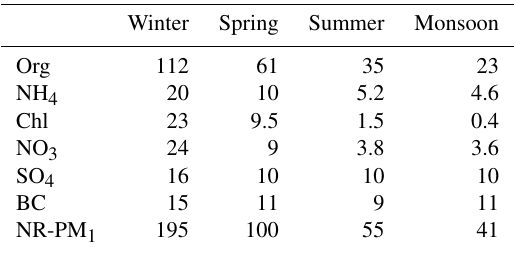
Table 1. Seasonal summary of PM 1 species – the arithmetic mean (AM) for hourly mass concentrations (µgm − 3 ). Adapted from Gani et al.